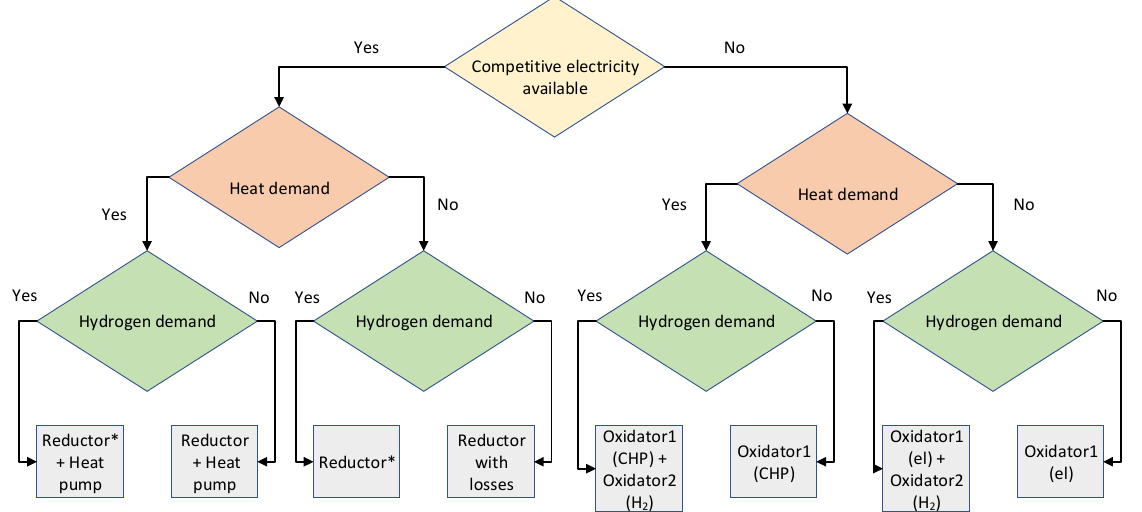
Figure 12. Expanded operational map of a polygeneration plant, based on the suggested process. The operational mode chosen depends on the availability of competitively priced electricity and the demands for heat and hydrogen. Reductor* refers to the reduction section being operated at elec ‐ trolyzer capacities greater than that required by the reactor.